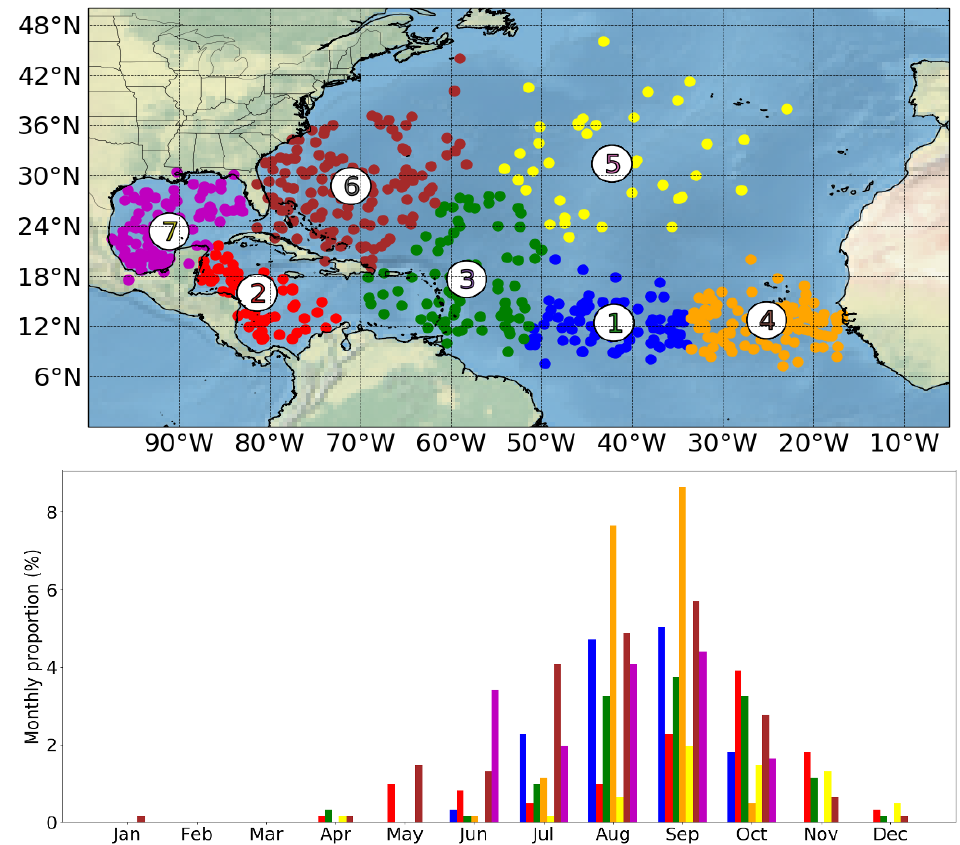
Figure 2. Map representation of TC genesis clusters ( top ) and monthly proportion of genesis for each cluster ( bottom ). The monthly proportion was computed as the proportion of genesis count in a month for a cluster and the genesis counts in the whole basin in the study period (1980–2019).